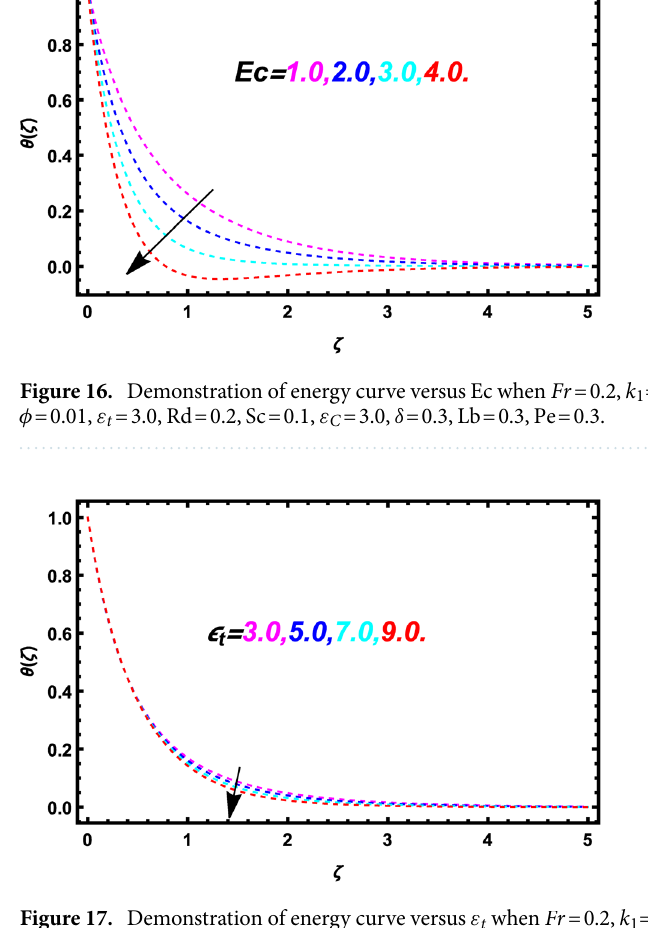
Figure 17. Demonstration of energy curve versus ε t when Fr = 0.2, k 1 = 0.1, k 2 = 0.3, M = 0.5, m = 0.2, Pr = 5.3, φ = 0.01, Ec = 0.3, Rd = 0.2, Sc = 0.1, ε C = 3.0, δ = 0.3, Lb = 0.3, Pe = 0.3.